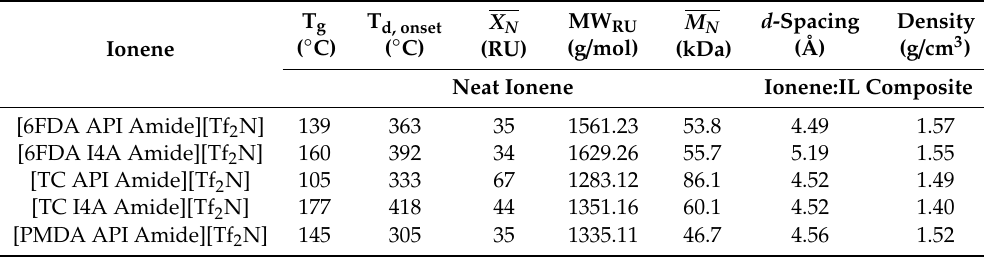
Figure 2. Graphic representing the incorporation of mono- and tris-imidazolium ionic liquid (IL) within the ionene matrix. The cartoon structures refer to the polymer and IL structures shown in Scheme 3. For example, pentagon are five-membered rings, hexagons are six-membered rings and circles are anions.